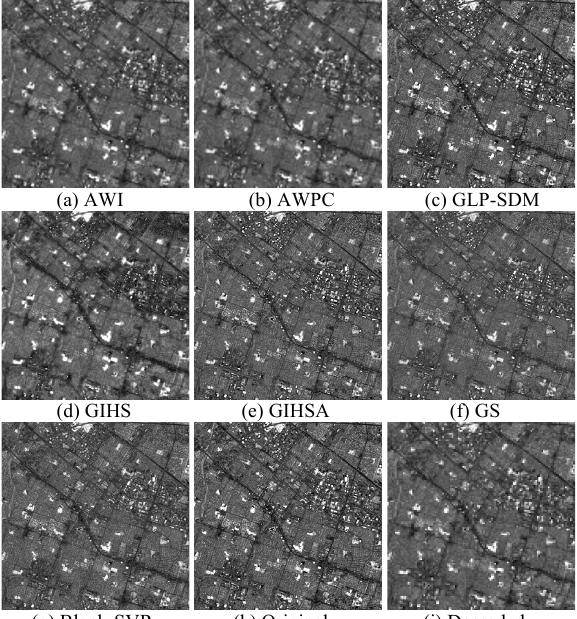
Figure 4. Pansharpened image in an urban area using 50% overlapping PAN